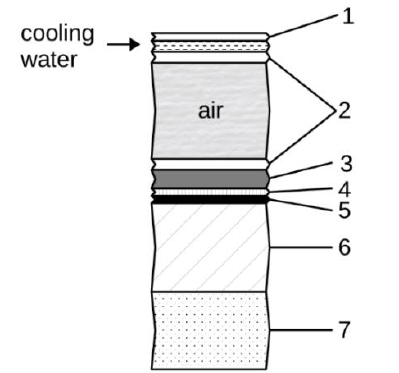
Fig. 6. Scheme of layers of Chen et al. heating bottom wall and cooling top wall. 1 plexiglass plate, 2 glass plate, 3 copper sheet, 4 mica sheet, 5 heater, 6 bakelite, 7 thermal insulation